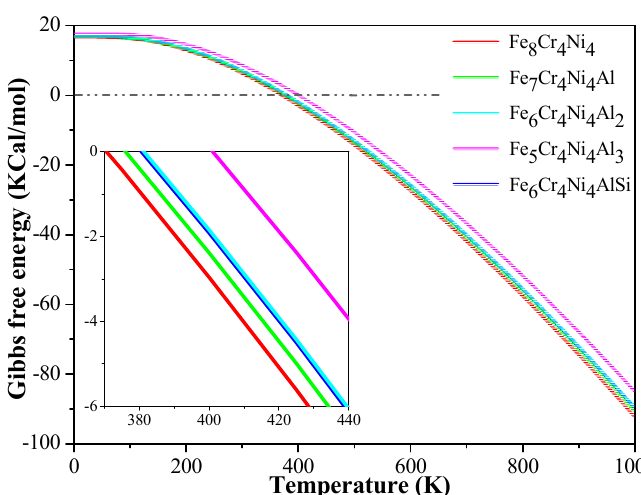
Figure 7. Relationships of Gibbs free energies with temperature of Fe 8 Cr 4 Ni 4 , Fe 7 Cr 4 Ni 4 Al,